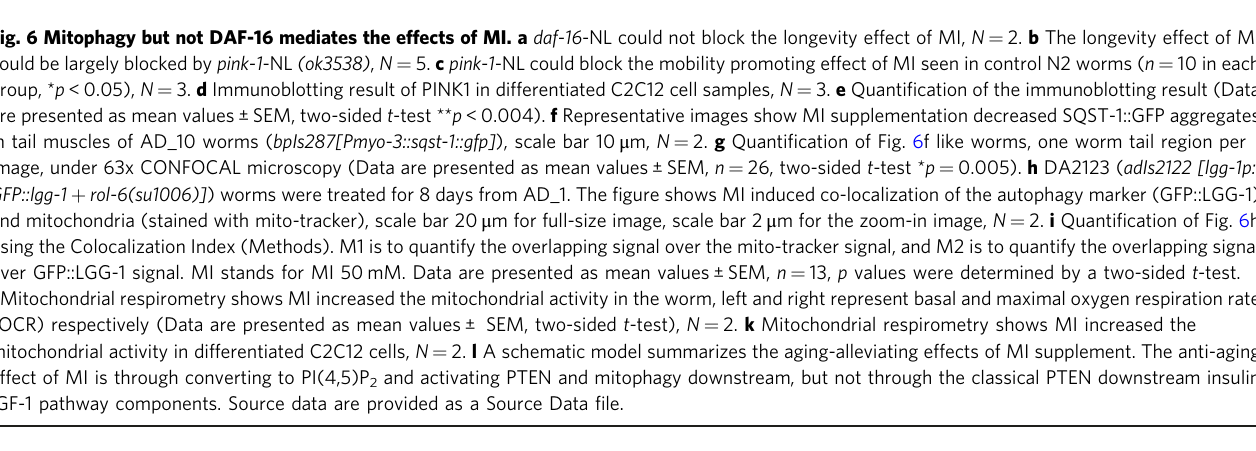
Fig. 6 Mitophagy but not DAF-16 mediates the effects of MI. a daf-16 -NL could not block the longevity effect of MI, N = 2. b The longevity effect of MI could be largely blocked by pink-1 -NL (ok3538) , N = 5. c pink-1 -NL could block the mobility promoting effect of MI seen in control N2 worms ( n = 10 in each group, * p < 0.05), N = 3. d Immunoblotting result of PINK1 in differentiated C2C12 cell samples, N = 3. e Quanti fi cation of the immunoblotting result